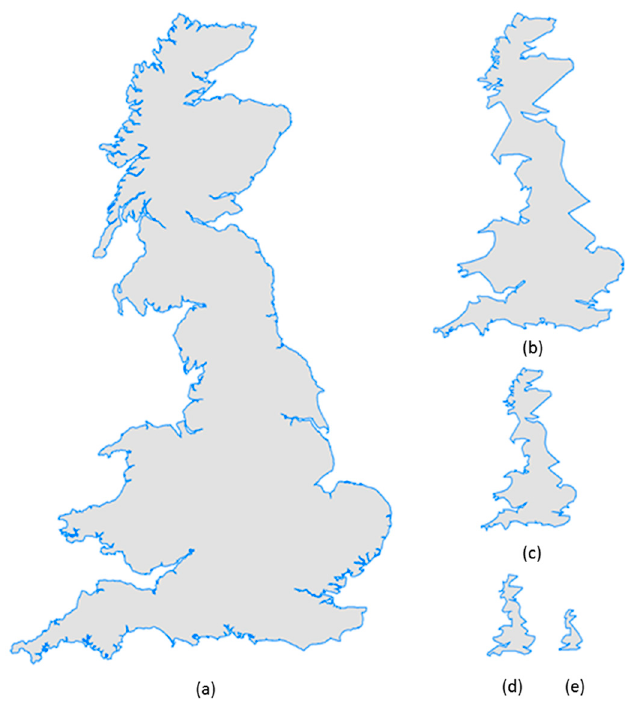
Figure 10. (Color online) A multiscale representation with the scaling ratio of 1 / 2 of the simplified result from level 1 to 5 (Panels a – e ) of the British coastline using the HD algorithm.